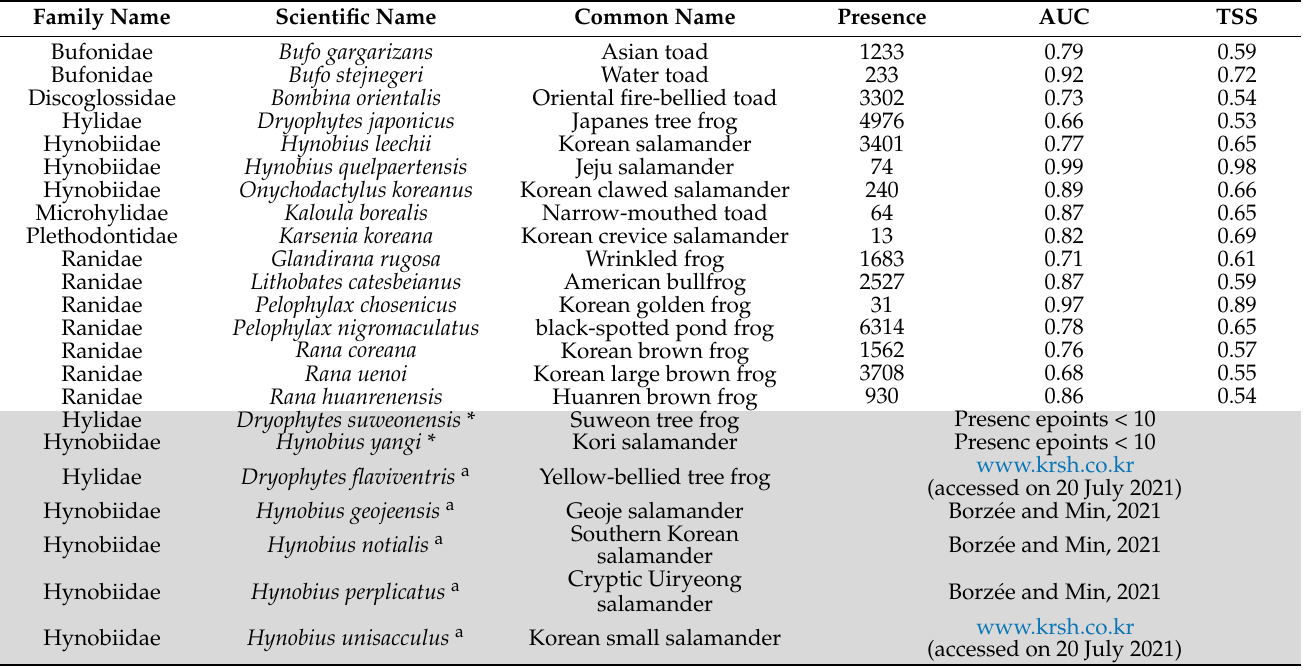
Table 1. List of amphibian species in South Korea.